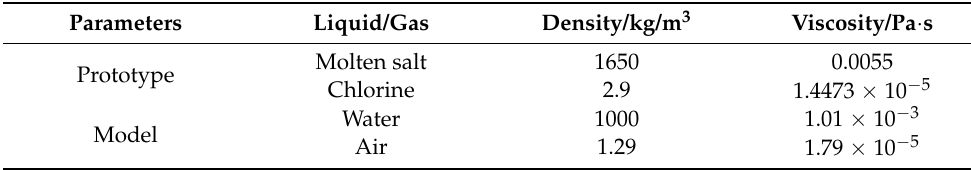
Figure 1. Schematic diagram of water model experiment (mm). Table 1. Physical parameters of prototype and model. Table 1. Physical parameters of prototype and